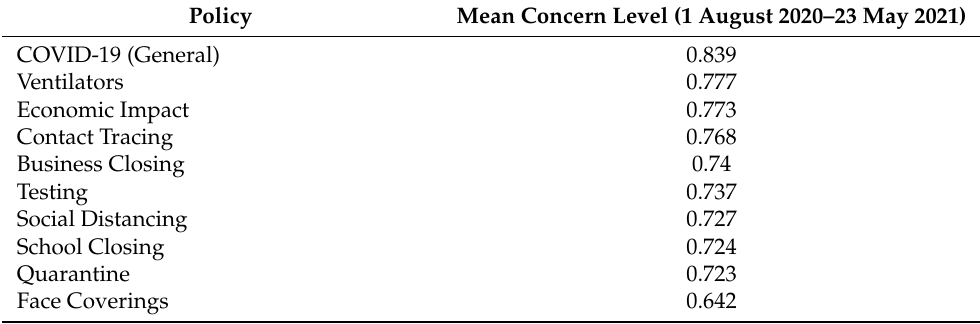
Table 3. Average Concern Levels from August 2020 to May